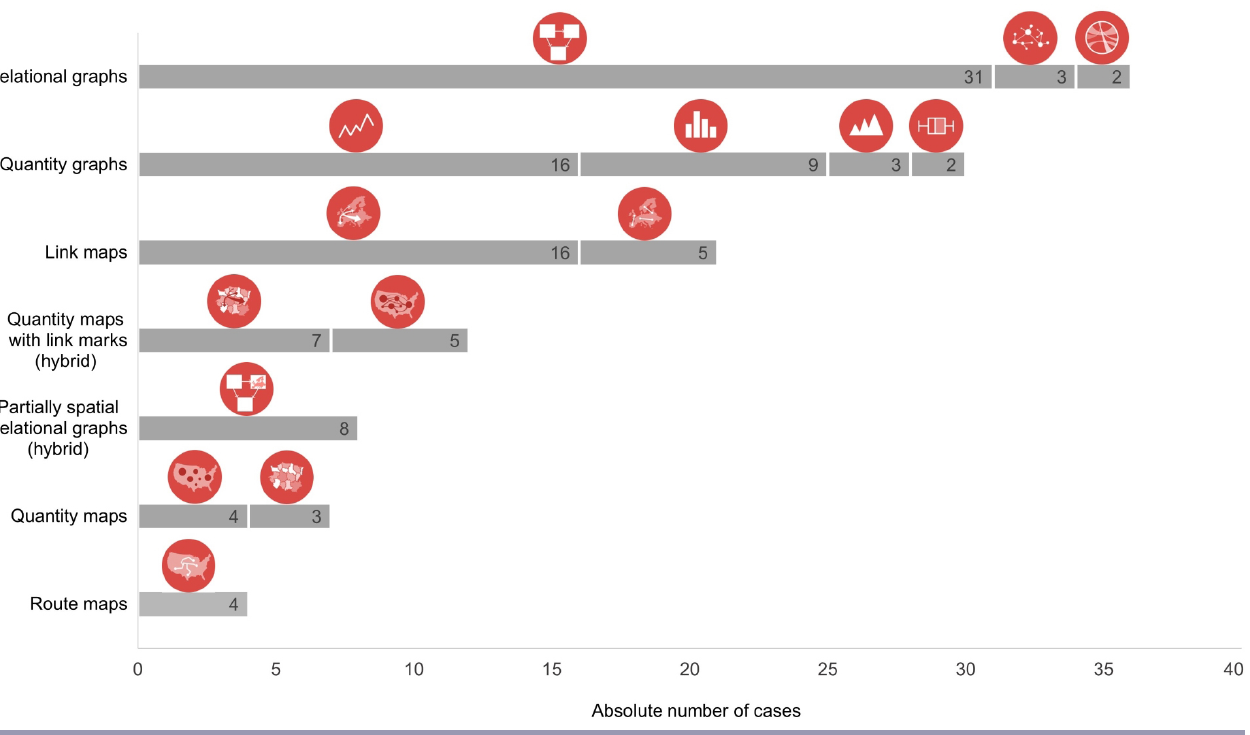
Fig. 8 . Frequency of visualization types by occurrence in cases (n = 118), with an indication of their composition of visualization techniques (see Fig. 7 for the meaning of the